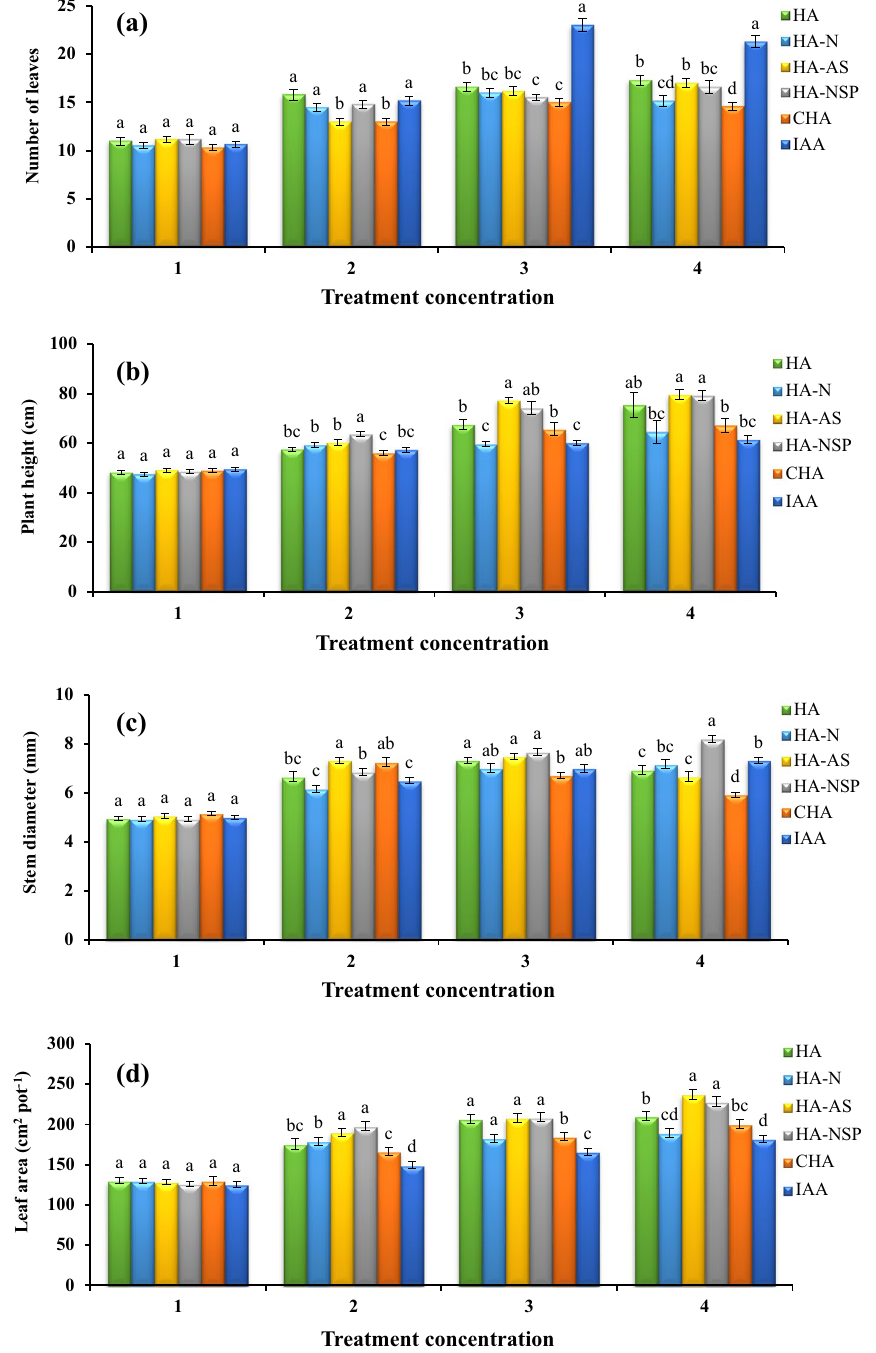
Figure 1. Comparison of average foliar application of experimental treatments on number of leaves ( a ), plant height ( b ), stem diameter ( c ) and leaf area ( d ) at treatment concentrations (levels 1, 2, 3 and 4 for HA, HA-N, HA-AS, HA-NSP and CHA treatments of 0, 200, 400 and 600 mg L −1 and 0, 10 –6 , 10 –5 and 10 –4 molar IAA). Different letters in each figure show significant difference at p ≤ 0.05 by Duncan multiple range test. HA, HA extracted from vermicompost without enrichment; HA-N, HA extracted from vermicompost enriched with 1% nitrogen; HA-NSP, HA extracted from vermicompost enriched with 1% nitrogen, 1% sulfur, and 1% phosphorus; HA-AS, HA extracted from vermicompost enriched with Azotobacter chroococcum (21Az) + Pseudomonas fluorescens (Ps 59); CHA, Commercial humic acid; IAA, Indole-3-acetic acid